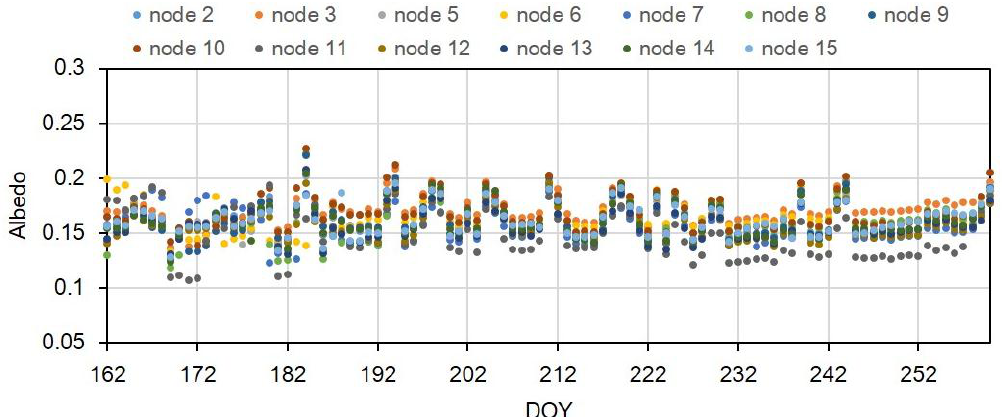
Figure 7. Time series of surface albedo over different cornfields over the study